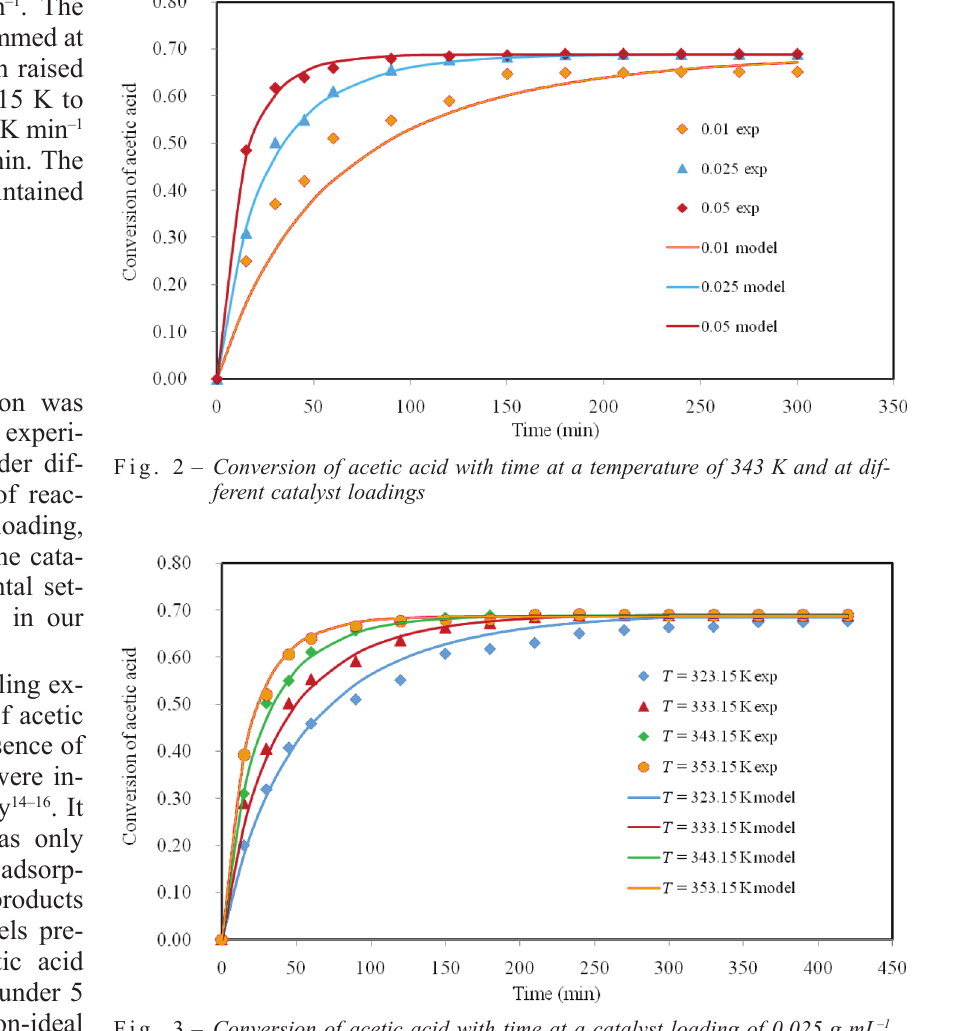
Fig. 2 – Conversion of acetic acid with time at a temperature of 343 K and at dif- ferent catalyst loadings